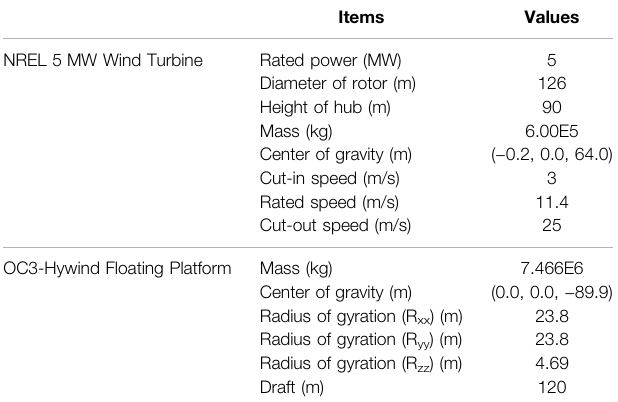
TABLE 1 | Performance parameters of the FOWT